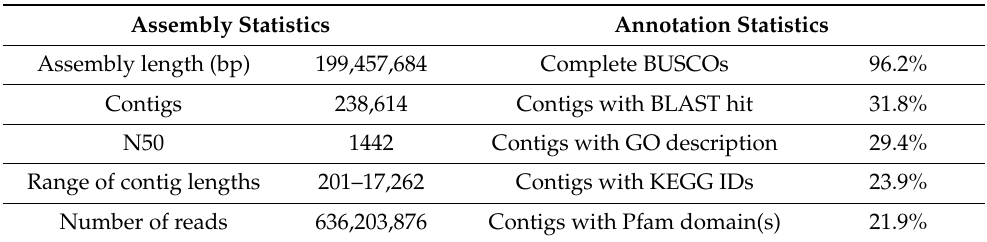
Table 1. De novo assembly and annotation statistics. 636 million paired-end reads were assembled into 238,614 contigs with Trinity. BUSCOs were compared with all other available Arthropod transcriptomes. BLAST, GO, KEGG, and Pfam domains were annotated using Trinotate.